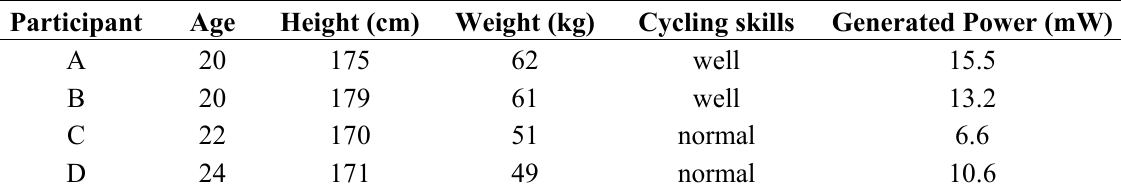
Table 2. Parameters of the energy